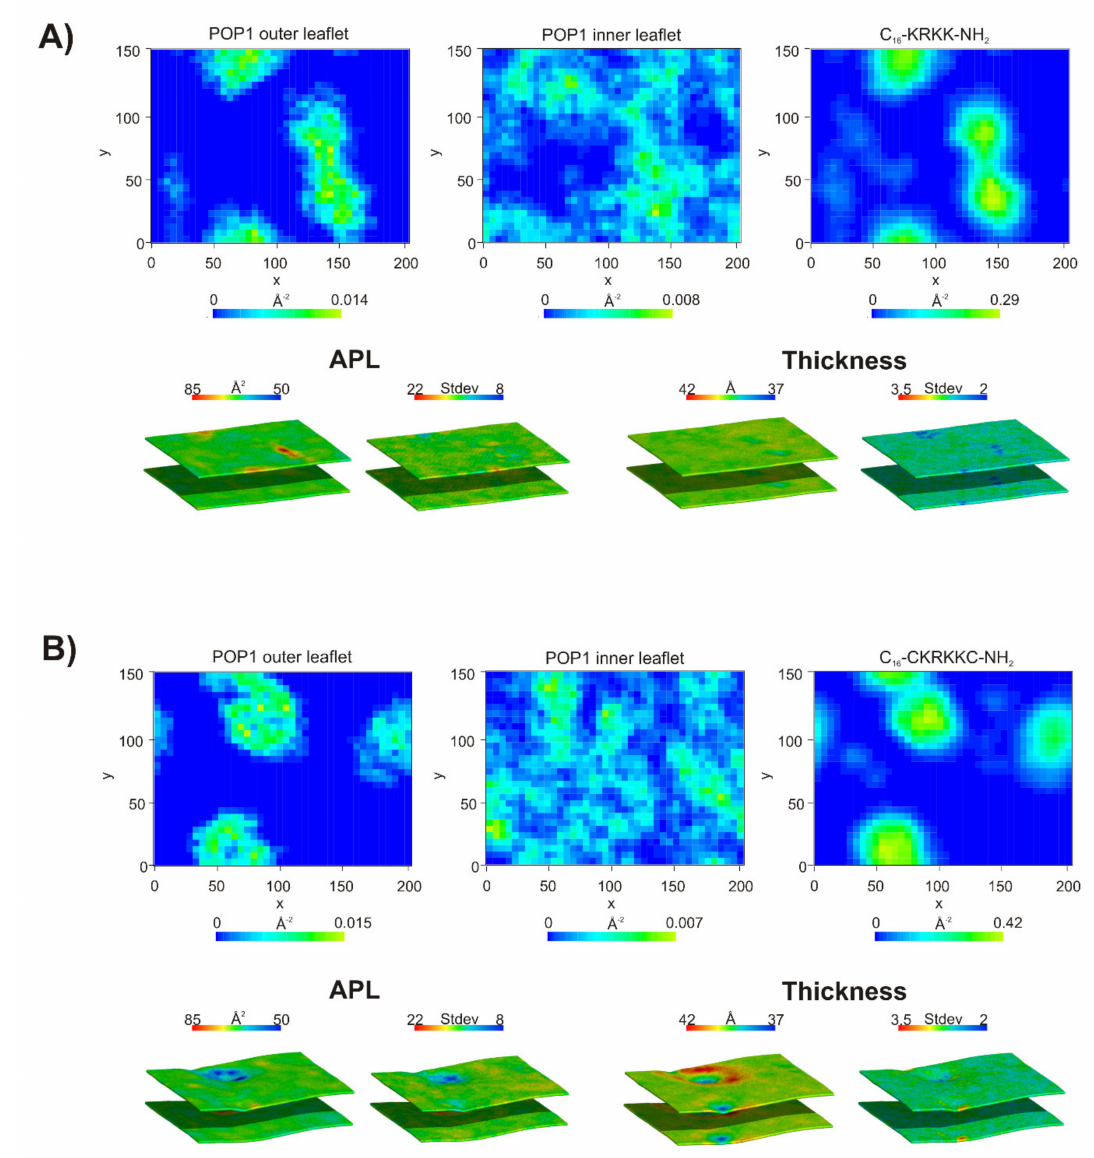
Figure 8. 2D density map of the lipopeptides and POPI lipids in the outer and inner leaflets of the POPC:POPE:POPS:POPI:ERGO membrane (a grid spacing was set to 5 Å), local area per lipid (APL) and standard deviations of the local membrane area per lipid (APL) and local thickness of the bilayer and standard deviations of the local thickness of the bilayer averaged over the last 100 ns of a total of 2 µ s CG MD (coarse-grained molecular dynamics) simulations of C 16 -KRKK-NH 2 ( A ) and C 16 -CKRKKC-NH 2 ( B ). Phosphate beads of the lipid headgroups were considered for